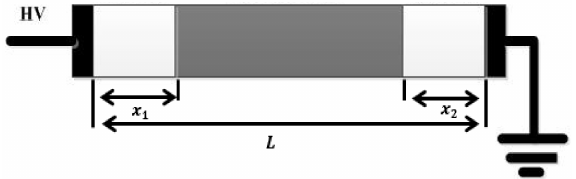
Figure 9. Sample configurations for two dry band neat each electrode.